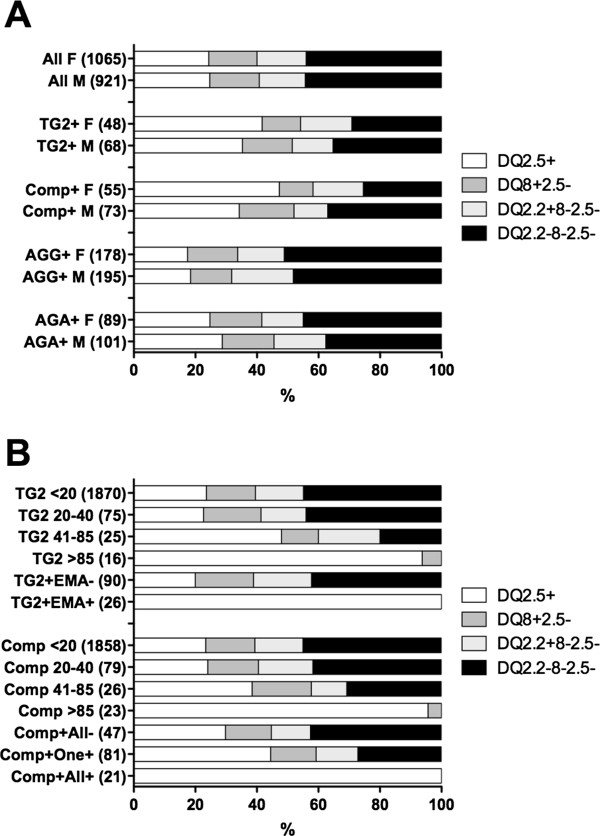
Human leukocyte antigen (HLA-DQ genetic status and celiac disease (CD)-specific serology. (A) HLA-DQ status of female (F) and male (M) community cohorts, and those who tested positive for anti-gliadin IgG (AGG) , anti-gliadin IgA (AGA), IgA specific for native human transglutaminase (TG)2, and composite TG2/DGP IgA/IgG (Comp.). Total numbers of subjects are in brackets. (B) HLA-DQ genotypes of women and men in the combined community cohorts classified by measured level of TG2 IgA and whether endomysial antibody (EMA) was also positive; or composite TG2/DGP IgA/IgG (Comp.) and whether all or at least one confirmatory serology (TG2 IgA, DGP IgA, or DGP IgG) was abnormal. Numbers of subjects are in brackets. DGP, Deamidated gliadin-derived peptide.